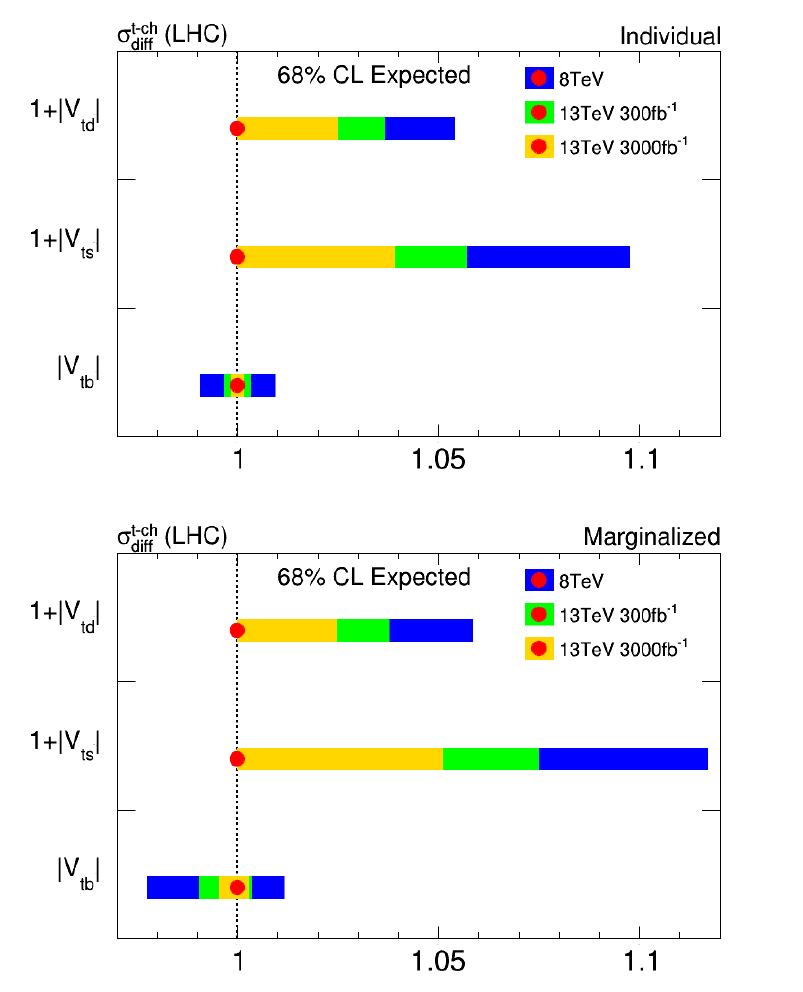
Figure 9 . Projected 68% con(cid:12)dence interval for individual (top) and marginalized (bottom) (cid:12)ts of the j V td j , j V ts j and j V tb j CKM elements from the di(cid:11)erential cross section measurements of the single top production at 13 TeV LHC with 300 fb (cid:0) 1 and 3000 fb (cid:0) 1 of recorded data. The 68% con(cid:12)dence intervals from the 8 TeV data are shown for